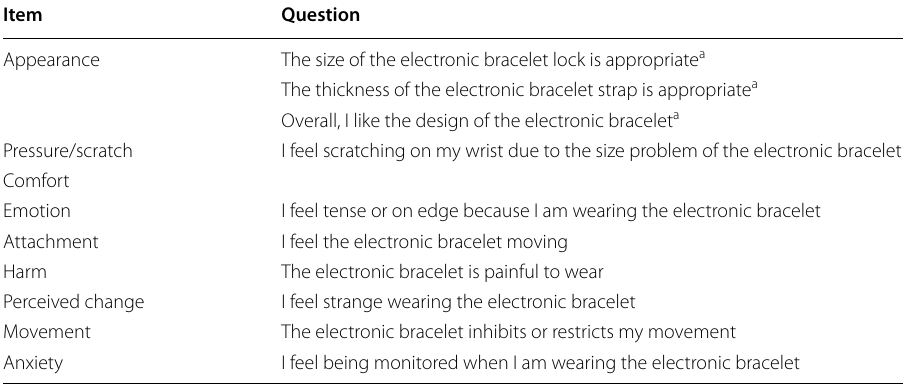
a Reversed items